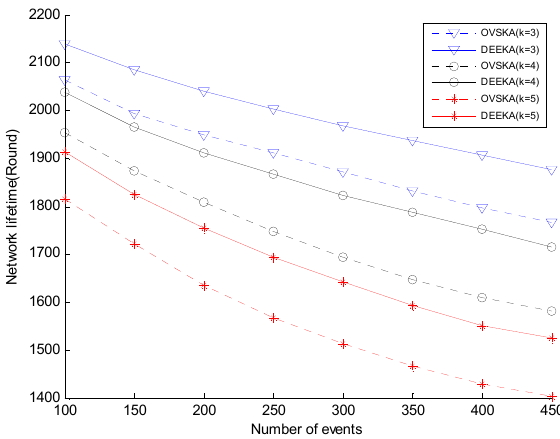
Figure 8. Network lifetime with event number and K-value.